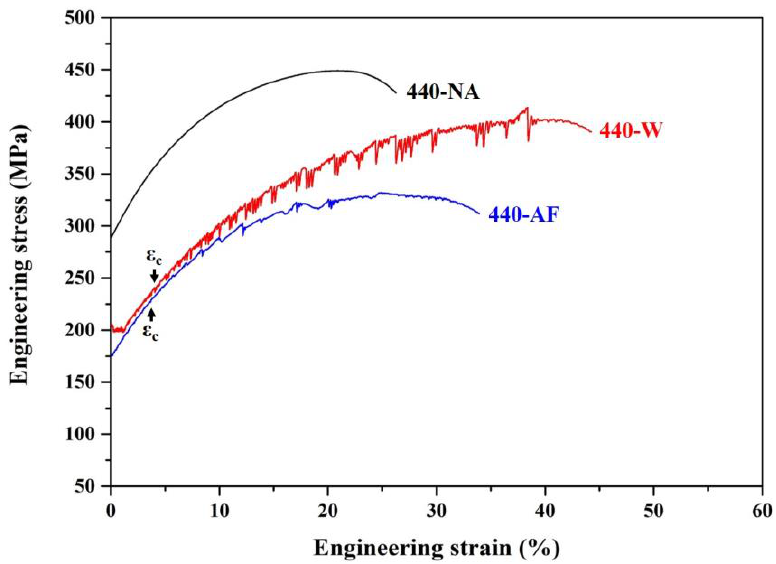
Figure 4. Stress – strain flow curve of FSPed specimens with different solid solubility. Figure 4. Stress–strain flow curve of FSPed specimens with different solid